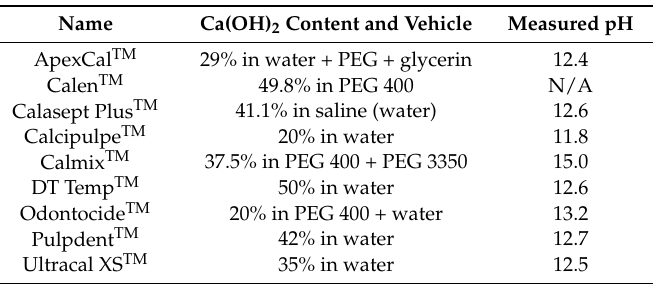
Table 1. Calcium hydroxide pastes used in